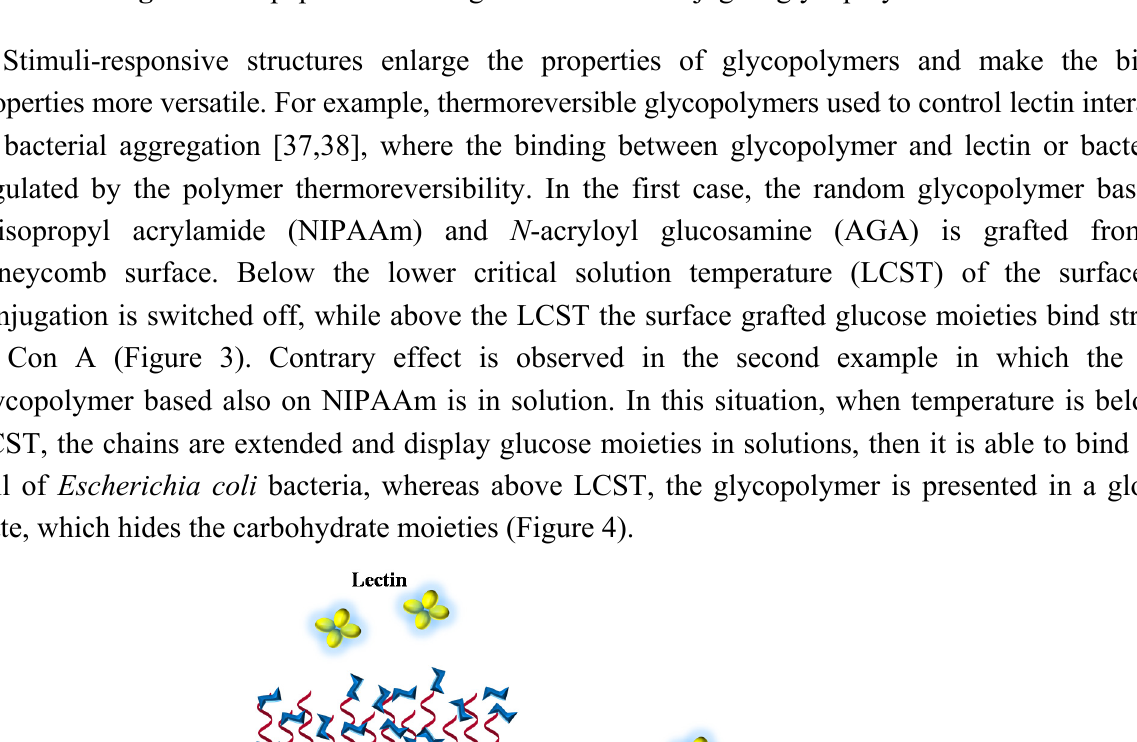
Figure 2. Tripeptide reduced glutathione-bioconjugate glycopolymer structure.